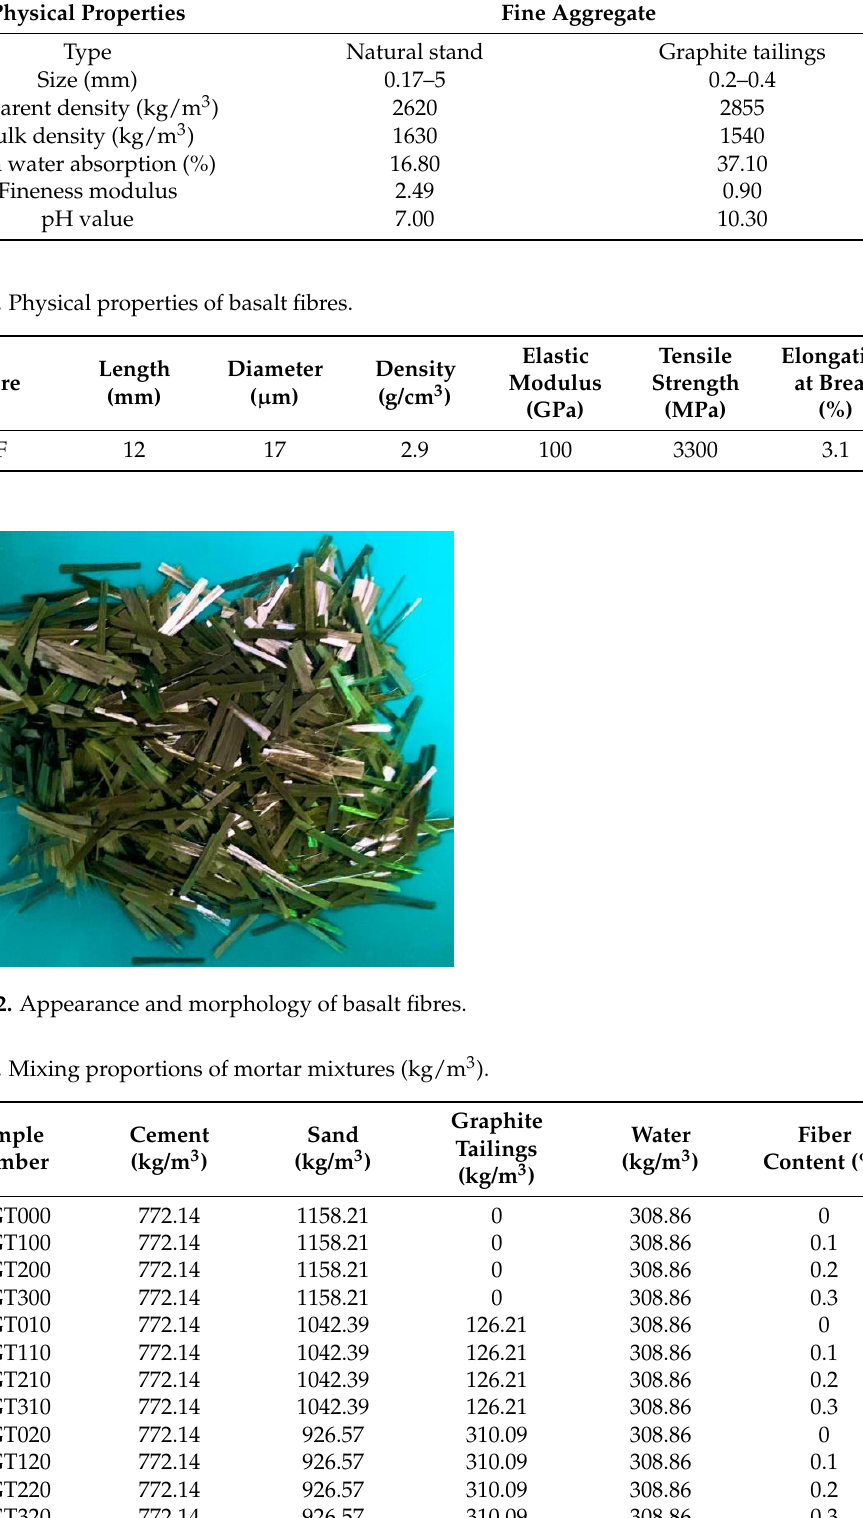
Table 3. Properties of sand and graphite tailings.